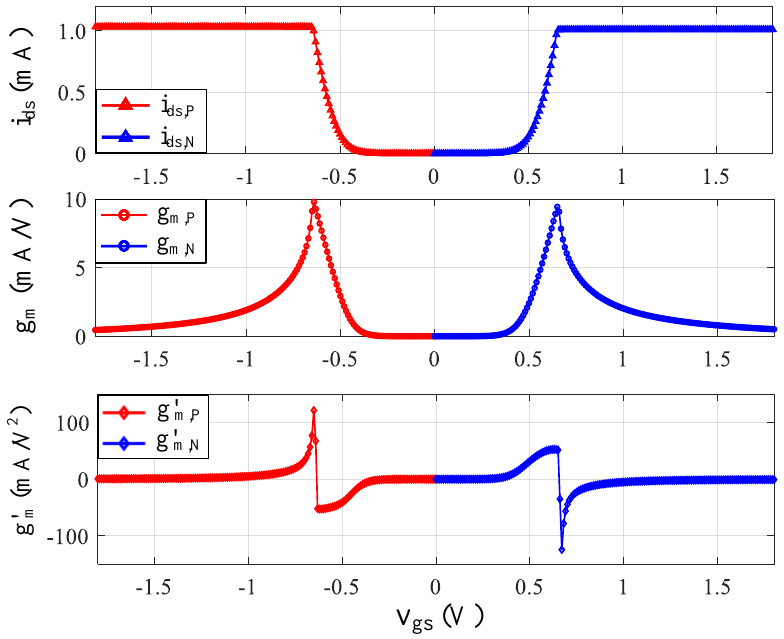
Figure 8. Simulated i ds , g m and g ’ m of a 240- µ m/0.18- µ m PMOS M P and a 120- µ m/0.18- µ m NMOS M N for the complementary resistive shunt-feedback amplifier.